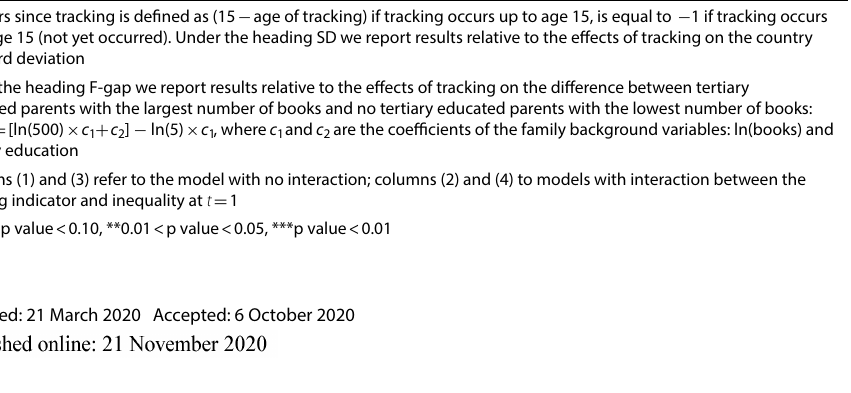
1 if tracking occurs −